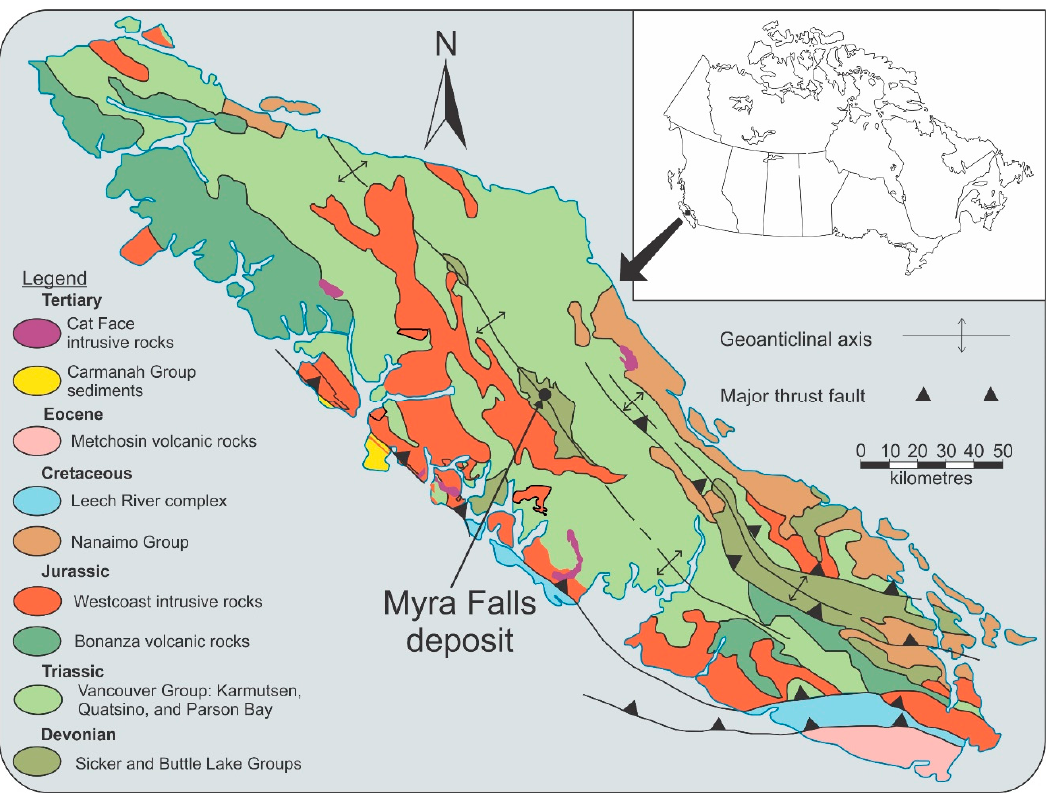
Figure 1. Regional geological map showing the major lithological units at the Myra Falls mine. Inset figure shows the location of the mine within Canada.